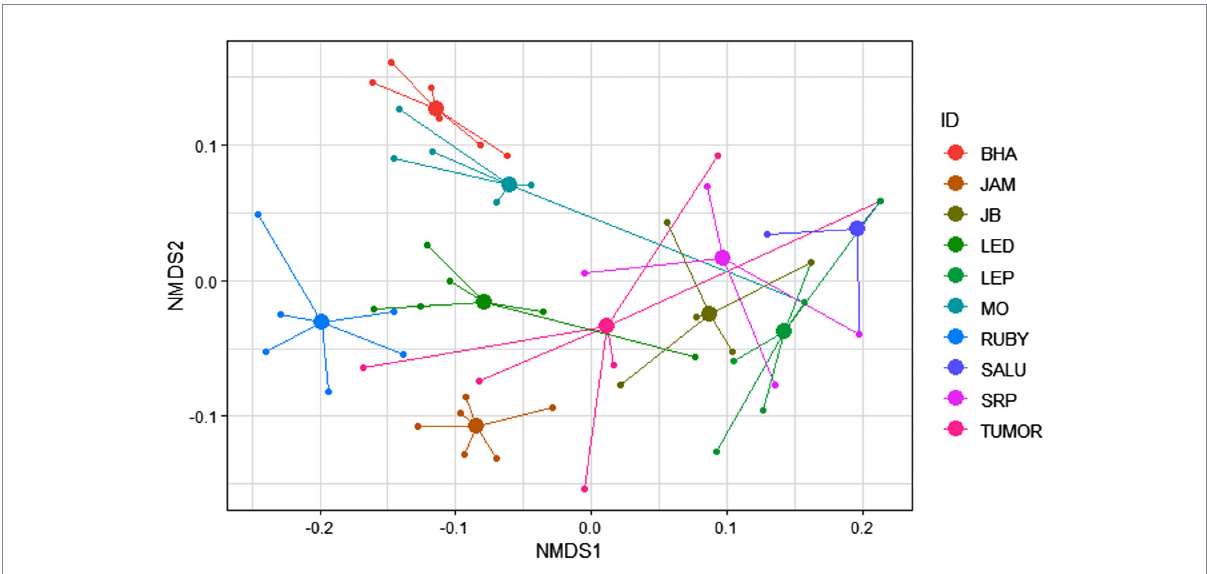
FIGURE 4 Variability of the 60 events of bottle-directed manipulative techniques, displayed by the 10 study bonnet macaques of the DV group during Task II, as indicated by the distance of each trial (small solid circles) from the mean value (large solid circles) of the six independent trials, conducted for each individual. This spider diagram represents a two-dimensional Non-metric Multi-Dimensional Scaling (NMDS) plot of all the 60 observed events, performed by the 10 individuals, represented by different